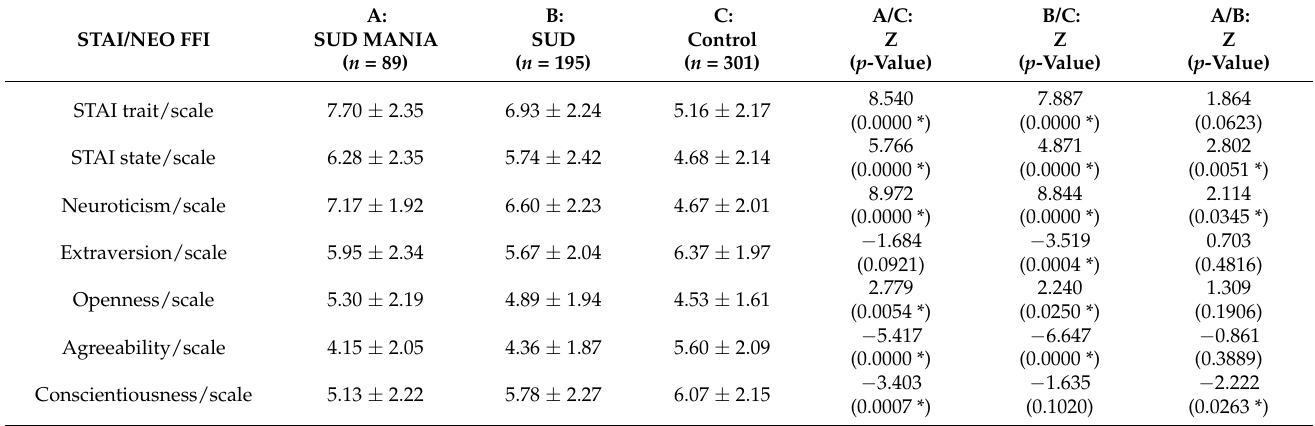
Table 4. The results of sten obtained in the STAI and NEO Five-Factor Inventory (NEO FFI) tests for healthy controls and all patients with a diagnosis of polysubstance use disorder and a maniacal syndrome (SUD MANIA) and patients with substance use disorder without mania